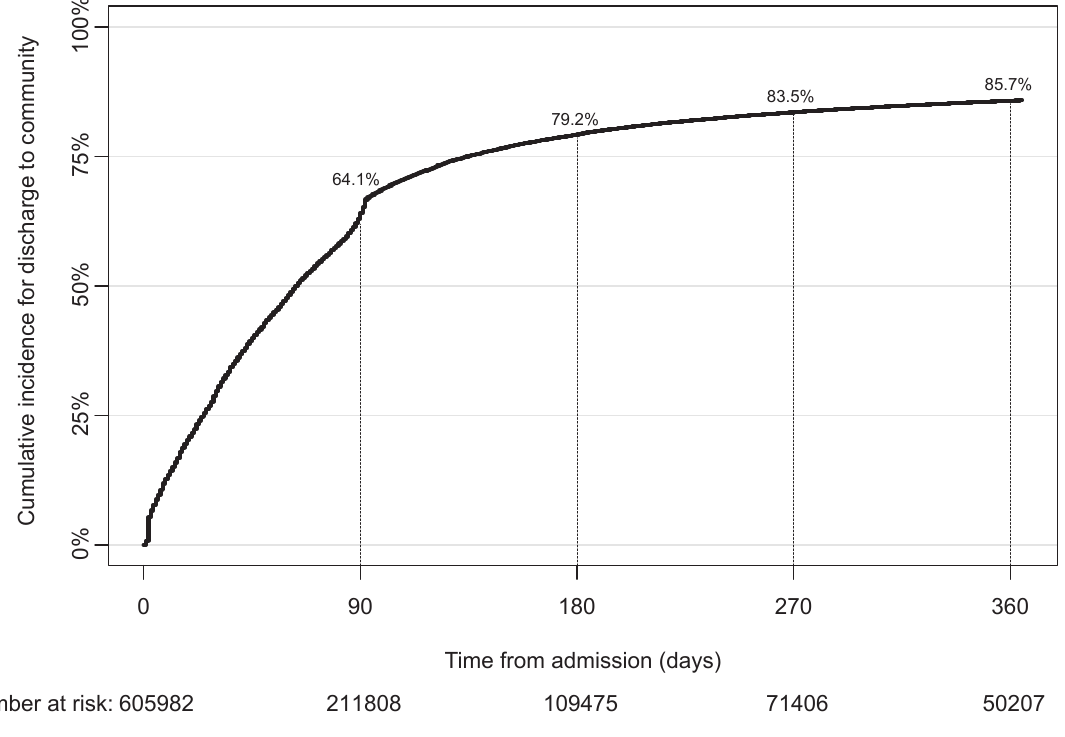
Figure 2. Cumulative incidence of discharge to community. Table 2. Cumulative incidence of discharge to community by type of hospital fee Type of hospital fee at